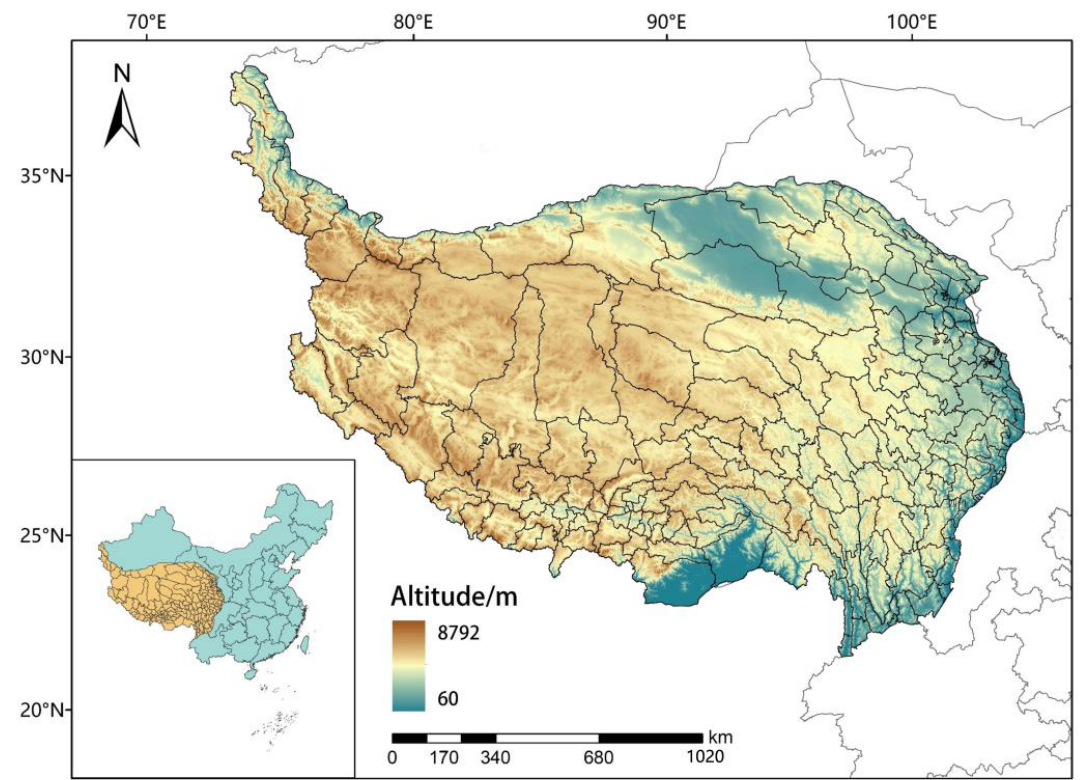
Figure 1. Geographic location of the study area.